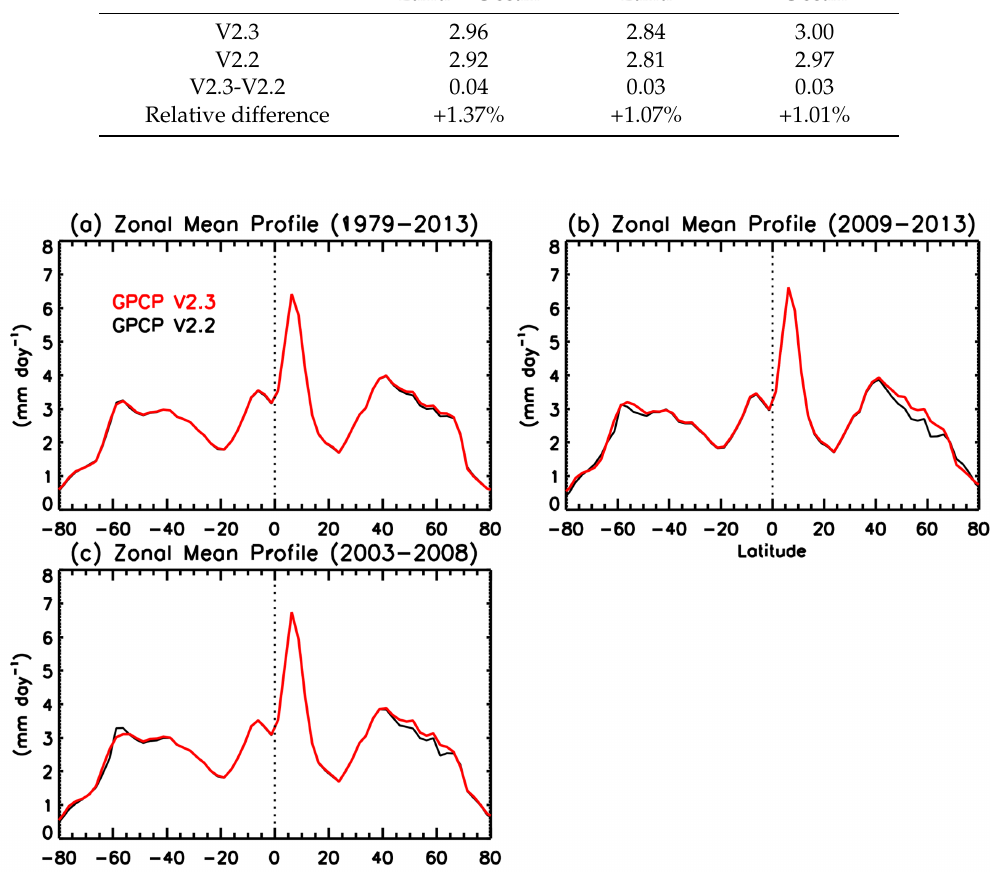
Figure 3. Zonal mean profiles of GPCP oceanic precipitation during three time periods discussed in the